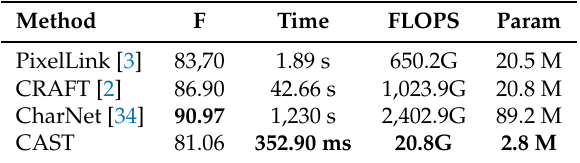
Table 6. Inference time comparison using a CPU with the ICDAR2015 dataset, where F represents the F1 score. Here ms and s represent milliseconds and seconds,